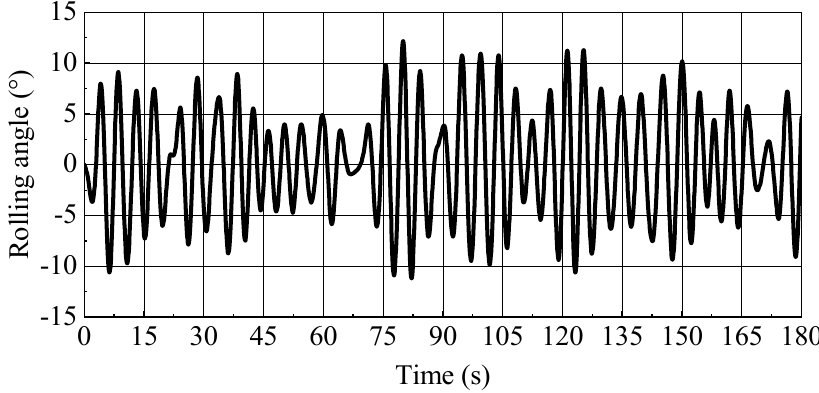
Figure 7. Time-series roll motion of the actual ship with zero forward speed in beam waves.